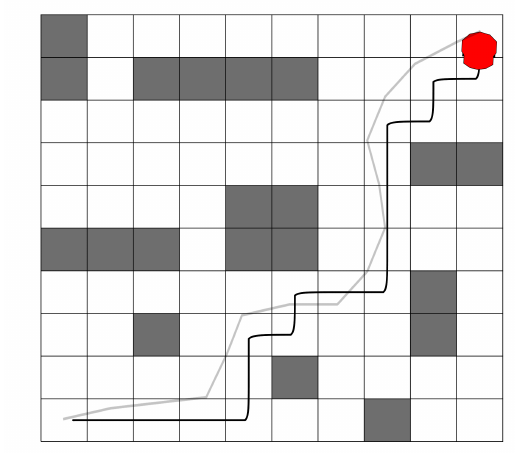
Figure 3. Comparison with Dynamic Planning Navigation Algorithm optimized with genetic algorithm (DPNA-GA) controller by Oliveira in [11].